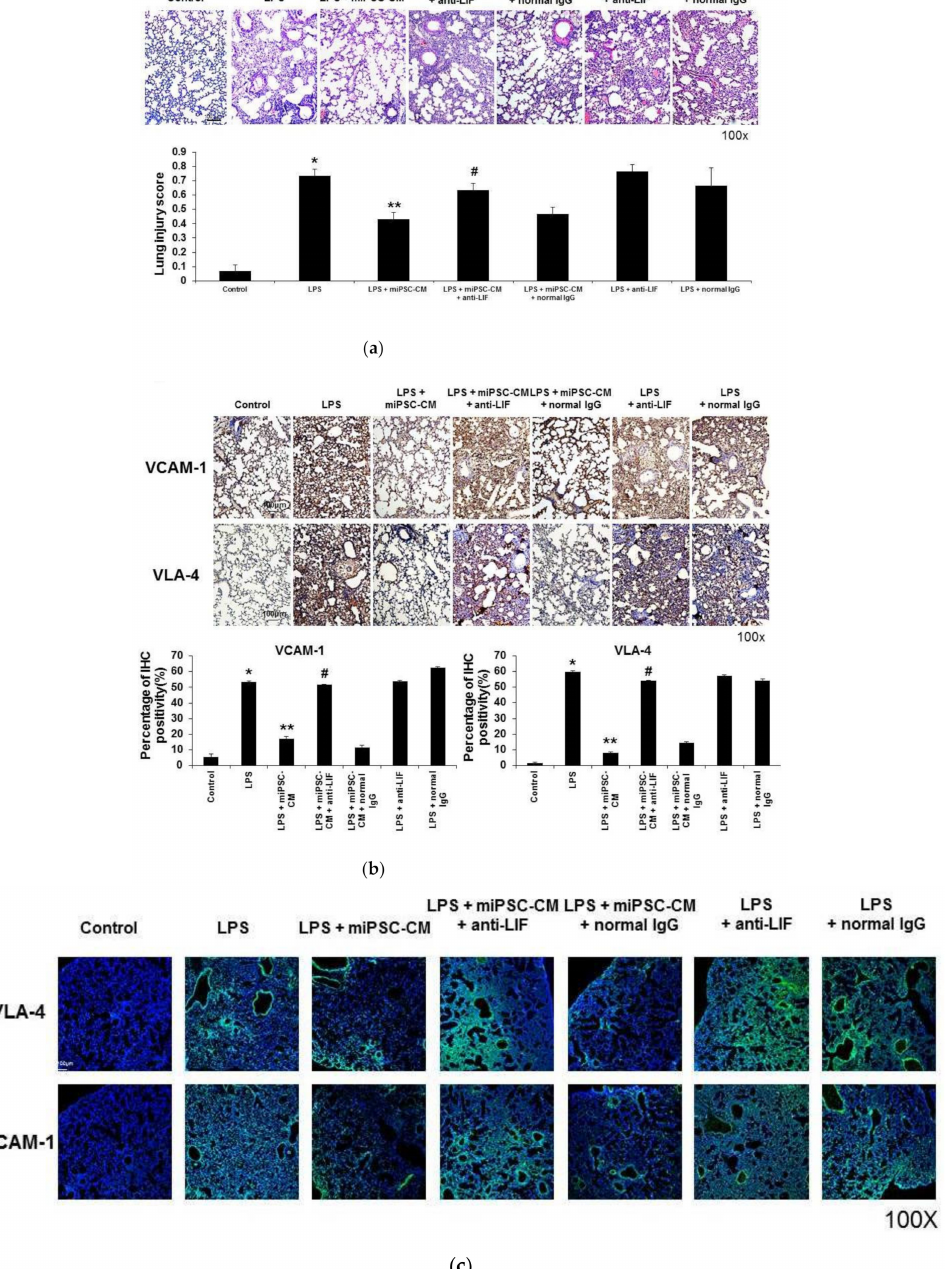
Figure 6. Adding the anti-LIF antibody reduced the beneficial effect of miPSC-CM on the severity of ALI and the TEM of neutrophils in LPS-induced ALI. In contrast, administering normal IgG had no beneficial effect on miPSC-CM in LPS-induced ALI. ( a ) Hematoxylin and eosin staining of lung sections (original magnification × 100) showed that the co-administration of anti-LIF antibody (LPS + miPSC-CM + anti-LIF) inhibited the beneficial effect of miPSC-CM on the pathological changes of lung injury in LPS-induced ALI mice. In contrast, adding normal IgG did not change the severity of lung injury in LPS-induced ALI mice with or without miPSC-CM treatment. Similarly, immunohistochemistry (IHC) staining of lung sections showed that adding the anti-LIF antibody inhibited the reduction effect of miPSC-CM on the expression of adhesion molecules of neutrophil TEM: VCAM-1 ( b ) and VLA-4 in LPS-induced ALI. ( c ) Immunofluorescence staining produced the same results as IHC. Data are presented as the mean ± SD. * p < 0.05, compared to control mice; ** p < 0.05, compared to LPS-induced ALI mice; # p < 0.05, compared to LPS-induced ALI mice received miPSC-CM; n = 6 per